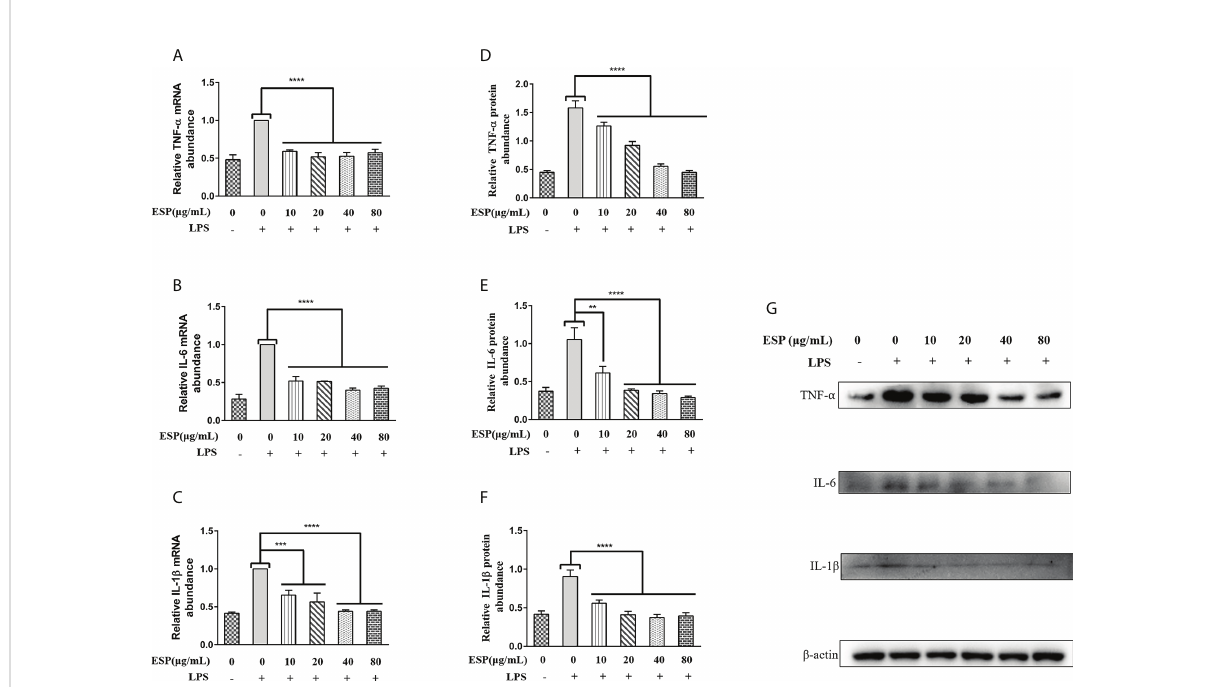
FIGURE 4 HcESPs reversed the LPS-induced upregulation of in fl ammatory mediators in PBMCs. Cells were stimulated with LPS (1 m g/mL) to establish an in fl ammation model, followed by incubation with different concentrations (0, 10, 20, 40, 80 m g/mL) of HcESPs at 37°C and 5% CO 2 for 24 h. A blank control group was set up (equal volumes of RPMI 1640 were used instead of LPS and HcESPs). (A – C) : Detection of relative transcript levels of TNF- a , IL-6, and IL-1 b in PBMCs by qPCR assays; (D – G) : Detection of relative protein expression levels of TNF- a , IL-6, and IL-1 b by Western blot; Data are presented as the mean±SEM from three independent experiments. Asterisks indicate signi fi cant differences at ** P <0.01, *** P <0.001, and **** P